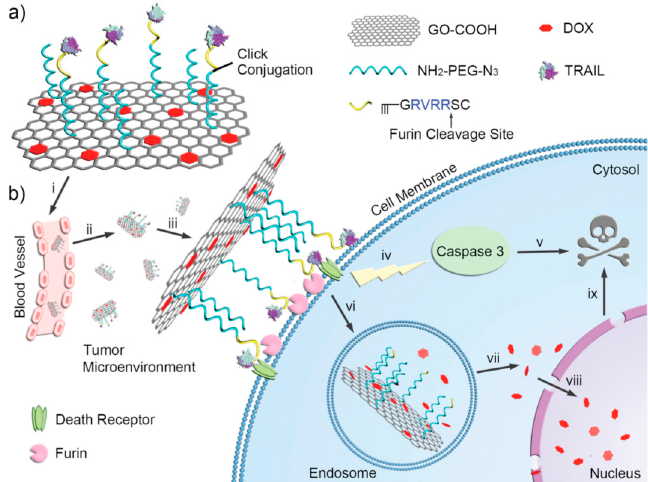
Figure 8. ( a ) Main components of tumor-necrosis-factor-related apoptosis-inducing ligand Figure (TRAIL)/DOX-FGO; ( b ) Site-specific delivery of TRAIL to cell membrance and DOX to nuclei for